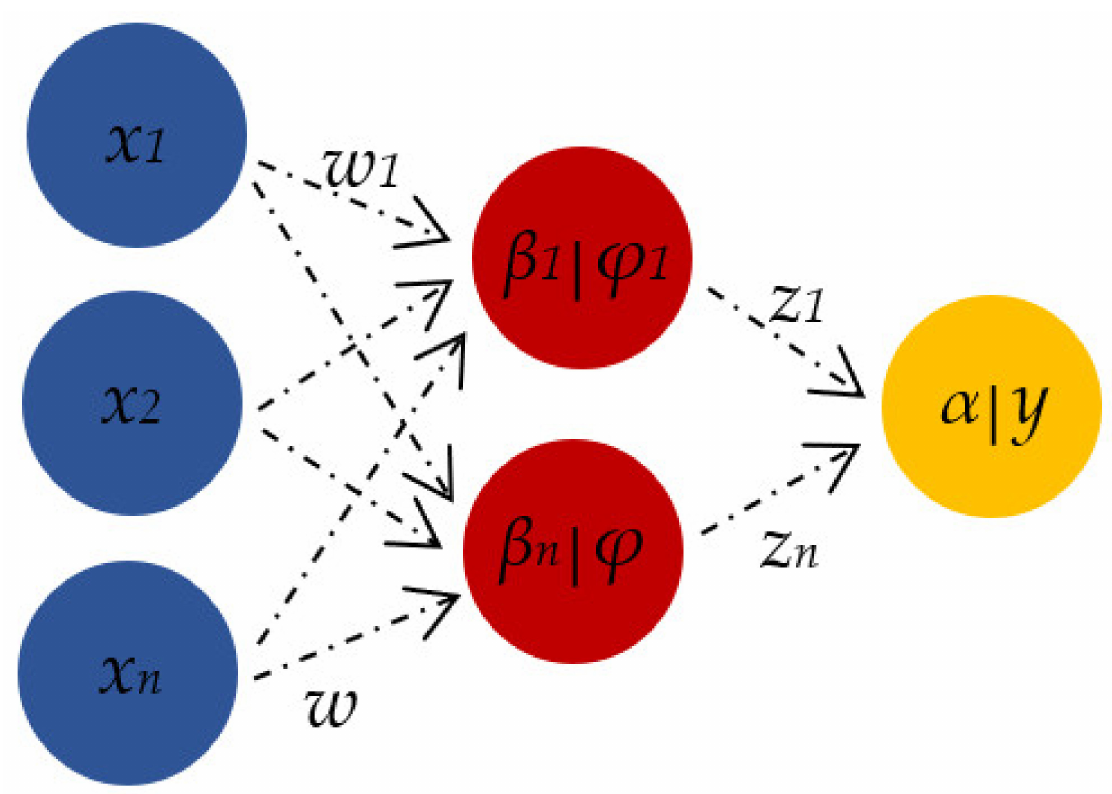
Figure 2. Relationship of neural network elements ( x —input neurons, ϕ —hidden neurons, y —output neuron). The incoming signal to each neuron was given by the value of the neuron multiplied by the weight, obtaining the total sum from other neurons (Equation (1)), and converting it using the activated function highlighted in the Equations (2) and (3). Meanwhile, the target output variable was computed in the same manner as the neurons in the hidden layers (Equation